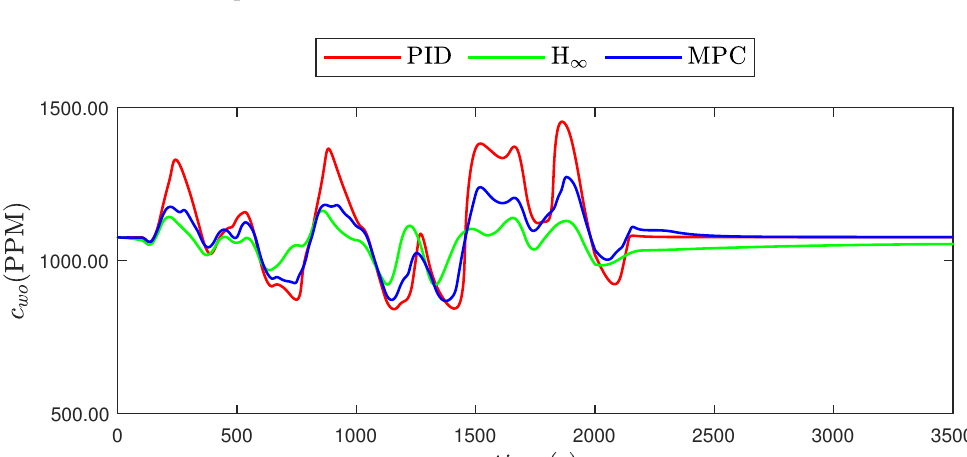
Figure 11. Pressure drop ration (PDR).